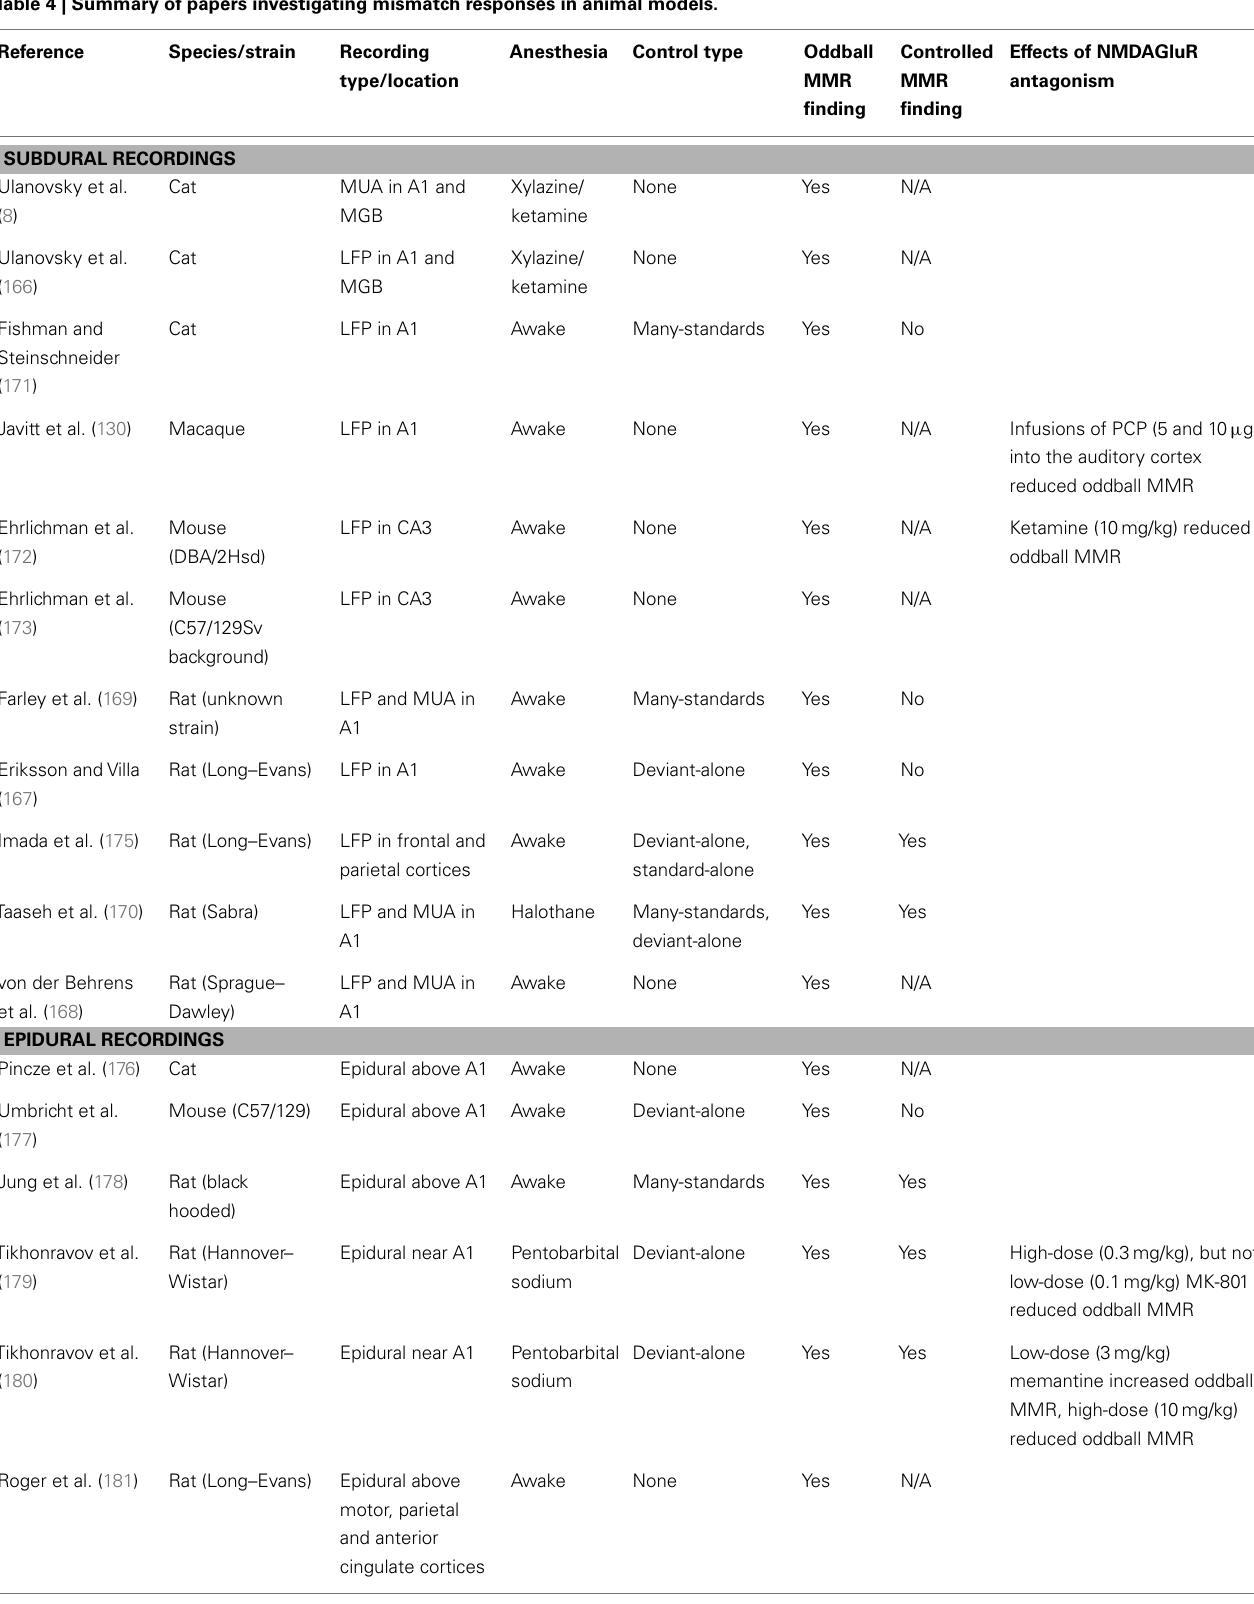
Table 4 | Summary of papers investigating mismatch responses in animal